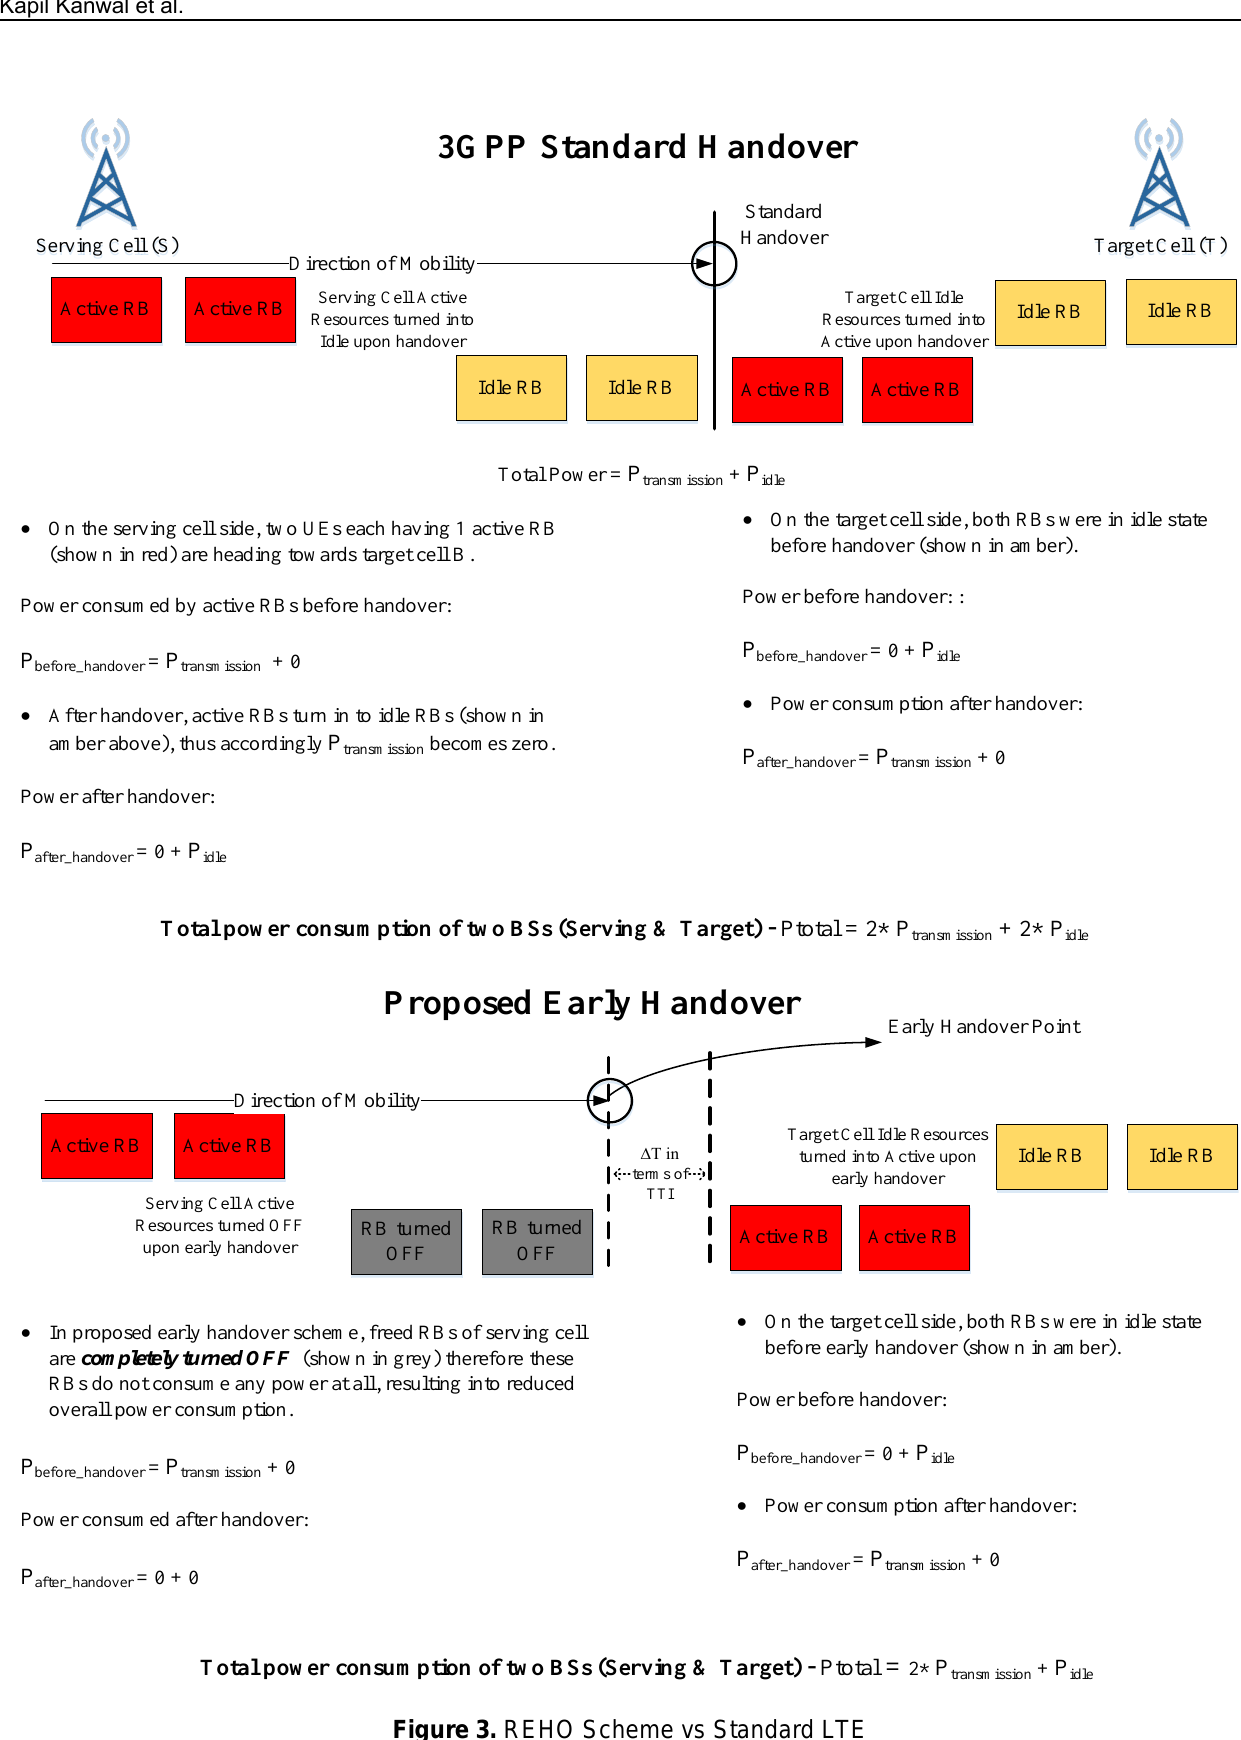
Figure 3. REHO Scheme vs Standard